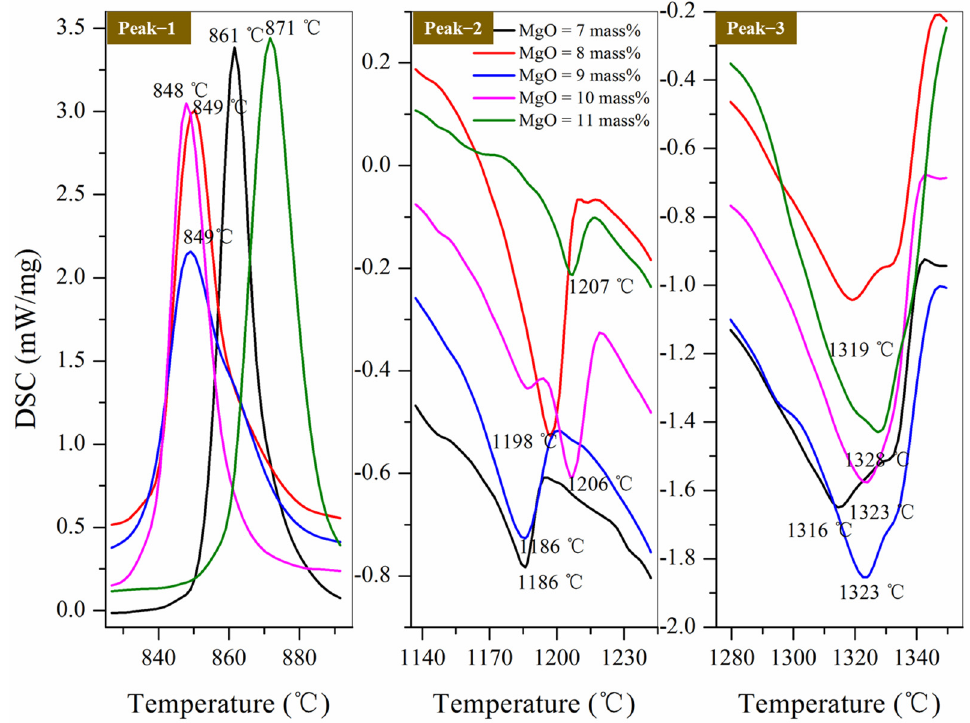
Figure 3. Local magnification of DSC curves of the BF slag in the temperature range of endothermic peak-1, exothermic peak-2, and peak-3.